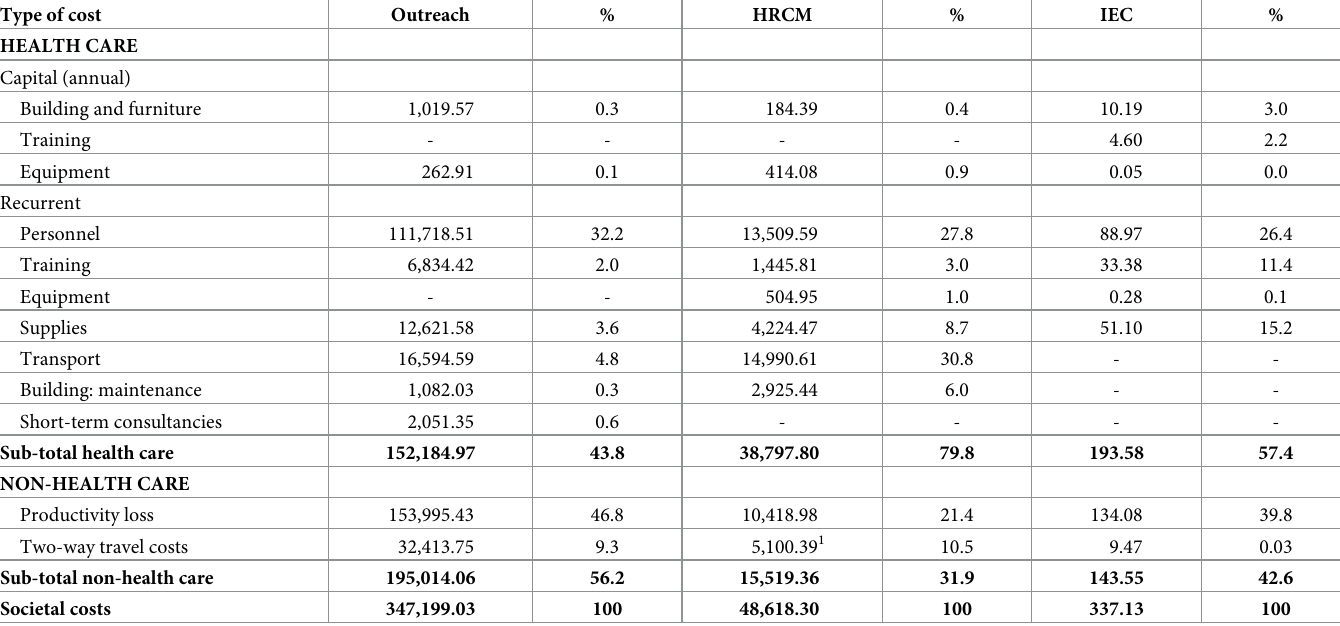
Table 1. Societal costs (in US$) and cost distribution profile (in % of societal costs) of outreach to Men who have Sex with Men and Transgender, harm reduction community meetings for Internal Drug Users, and Information, Education and Communication programs at Maternal and Child Health Posts in 2016 in Bandung,